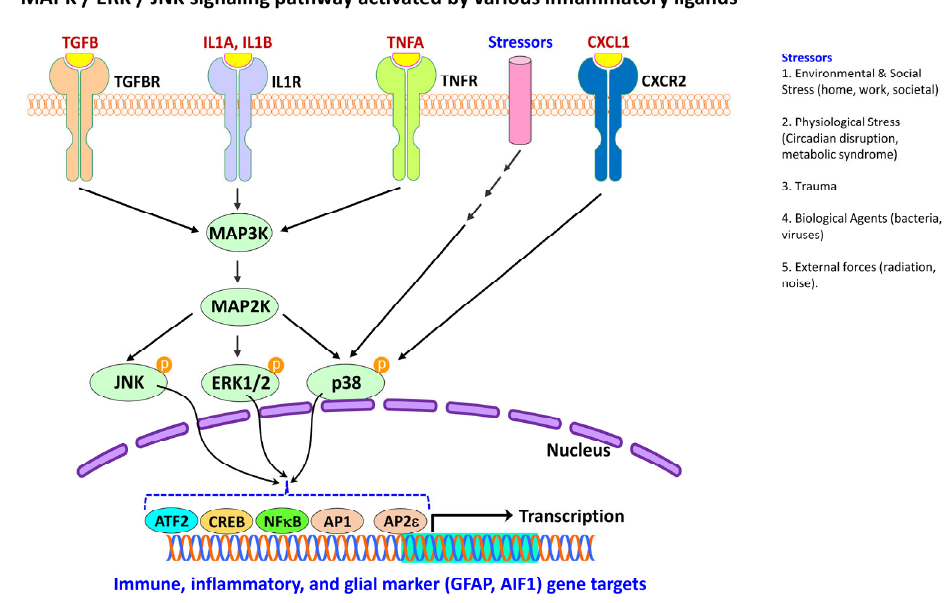
Figure 8. MAPK/ERK/JNK signaling in neuroinflammatory response. Schematic representation depicts MAP kinase activation by growth factors, stressor and cytokines which triggers a phosphorylation cascade. Agonist binding to TGFBR, IL1R, TNFR, stress receptors or CXCR2 leads to activation of the MAP3K, which has potential to activate various other MAP kinases by phosphorylating and activating the respective MAP2K. MAP2K has a restricted specificity for MAP kinase substrates. Upon activation, JNK, ERK1/2, and p38 further regulate gene transcription through activation and recruitment of transcription factors such as ATF2, CREB, NFkB, AP1 and AP2 ε to the nucleus to regulate transcription of immune and inflammatory genes including glial markers, e.g., GFAP and AIF1. Arrows indicate the activation process in the signaling cascade and multiple arrows indicate several intermediates in the signaling cascade. AIF1, allograft inflammatory factor 1 (also known as IBA1, ionized calcium-binding adapter molecule 1); AP1, activator protein 1 (also known as JUN, Jun protooncogene AP1 transcription factor subunit or V-Jun avian sarcoma virus 17 oncogene homolog); AP2 ε , transcription factor AP 2 epsilon (also known as TFAP2E); ATF2, activating transcription factor 2; CREB, cyclic AMP response element binding protein; CXCL1, C ‐ X ‐ C motif chemokine ligand 1; CXCR2, C ‐ X ‐ C motif chemokine receptor 2; ERK 1/2, extracellular signal ‐ regulated kinase 1 and 2; GFAP, glial fibrillary acidic protein; IL1A, interleukin 1alpha; IL1B, interleukin 1 beta; IL1R, interleukin 1 receptor; JNK, c ‐ Jun N ‐ terminal kinase; MAP2K, mitogen activated protein kinase kinase; MAP3K, mitogen activated protein kinase kinase kinase; NFkB, nuclear factor kappa ‐ B; P, phosphate group; p38, p38 mitogen activated protein kinase (p38 MAPK); TGFB, transforming growth factor beta; TGFBR, transforming growth factor beta receptor; TNFA, tumor necrosis factor alpha; TNFR, tumor necrosis factor receptor.